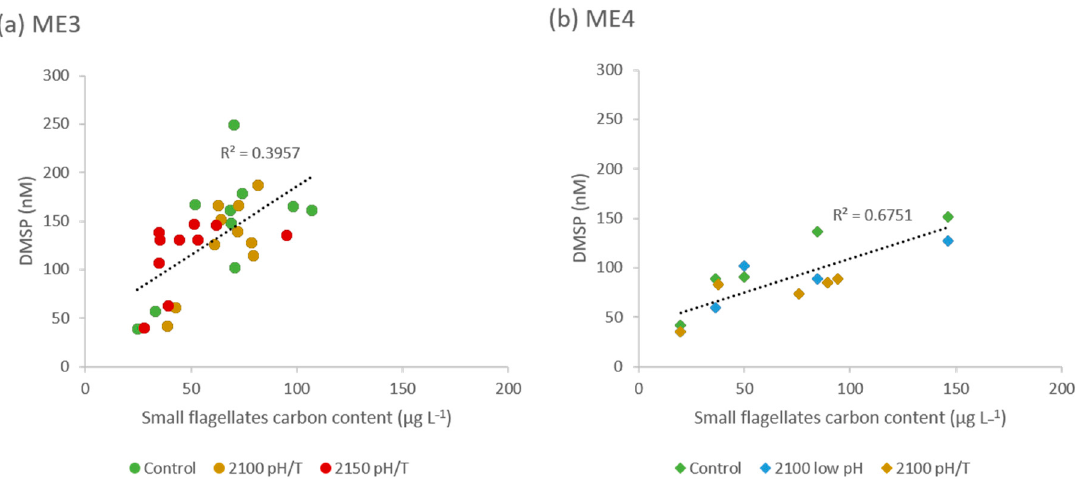
Figure 5. Relationship between DMSP concentration (in nmol L − 1 ) and small flagellates’ carbon content (in µ g L − 1 ) in the different treatments of ( a ) ME3 and ( b ) ME4.